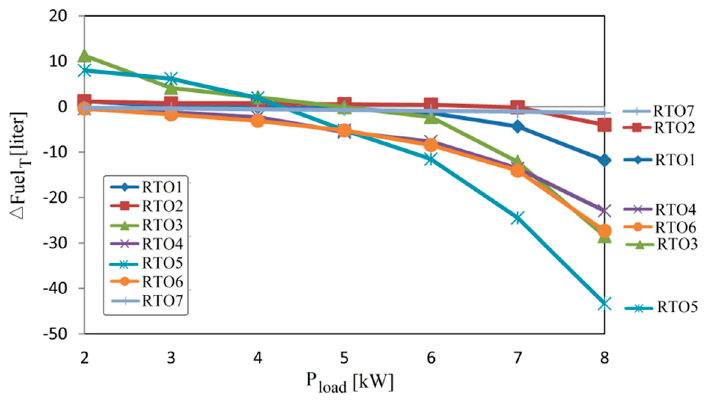
Figure 2. Fuel economy for k fuel = 0 and different P load .